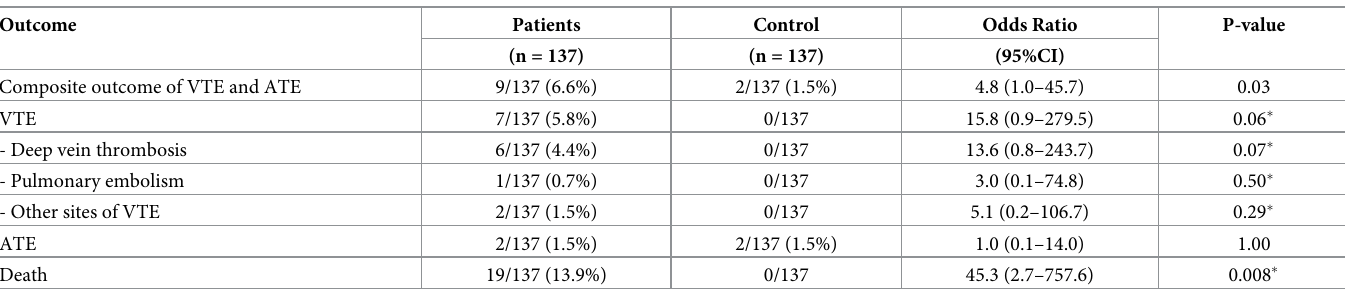
Table 4. Comparison of outcomes in cohort and control groups.